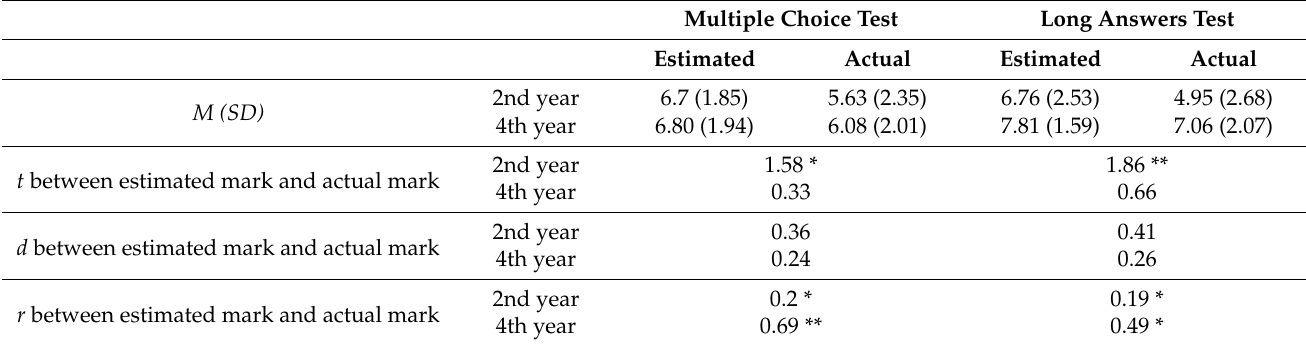
Table 2. Analysis of the students’ predictive competence regarding test